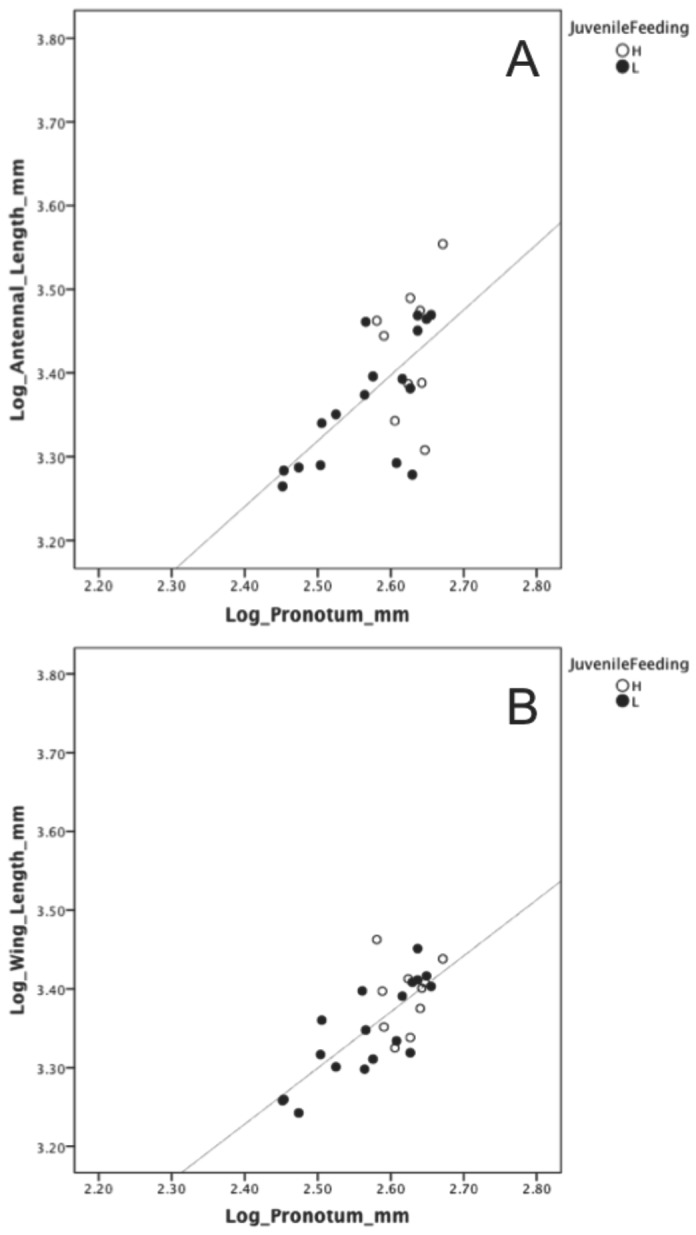
Male body size and antennal length/wing length.Scattergraphs showing the relationship between male body size and antennal length (A), and male body size and wing length (B). Body size was a significant predictor of antennal and wing length for low feeding treatment males (slope = 0.7432 and 0.7313, respectively), but not for high feeding treatment males.